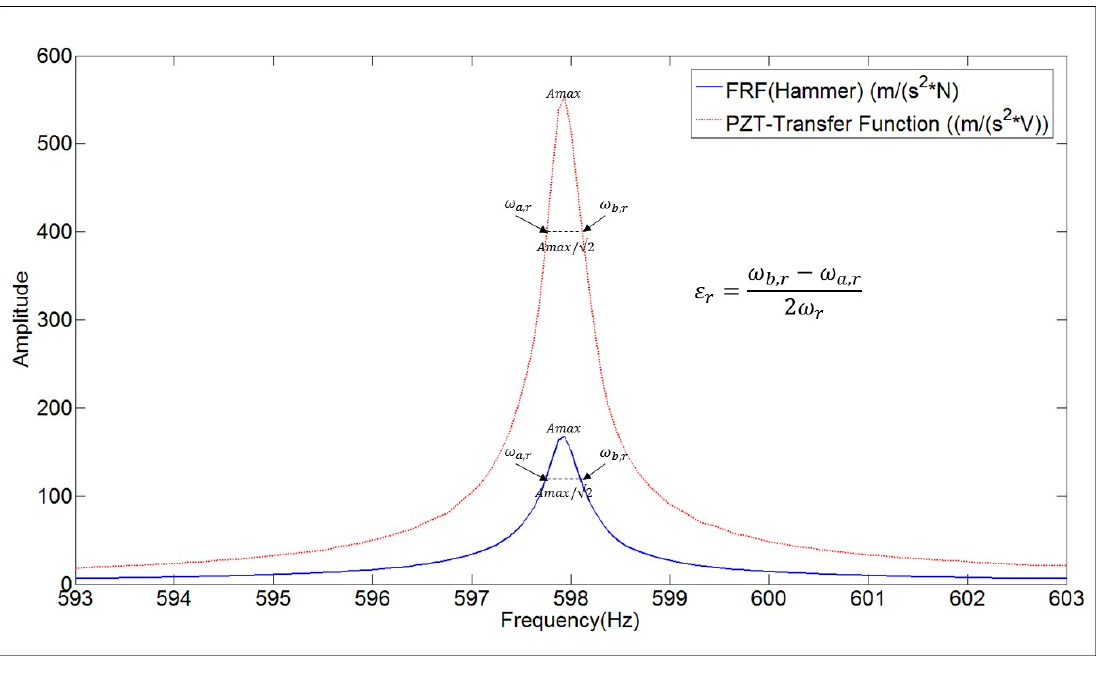
Figure 9. Damping Ratio estimation with the half power method for the FRF and for the transfer function ((m/s 2 )/V ) obtained with the PZT (chirp excitation).